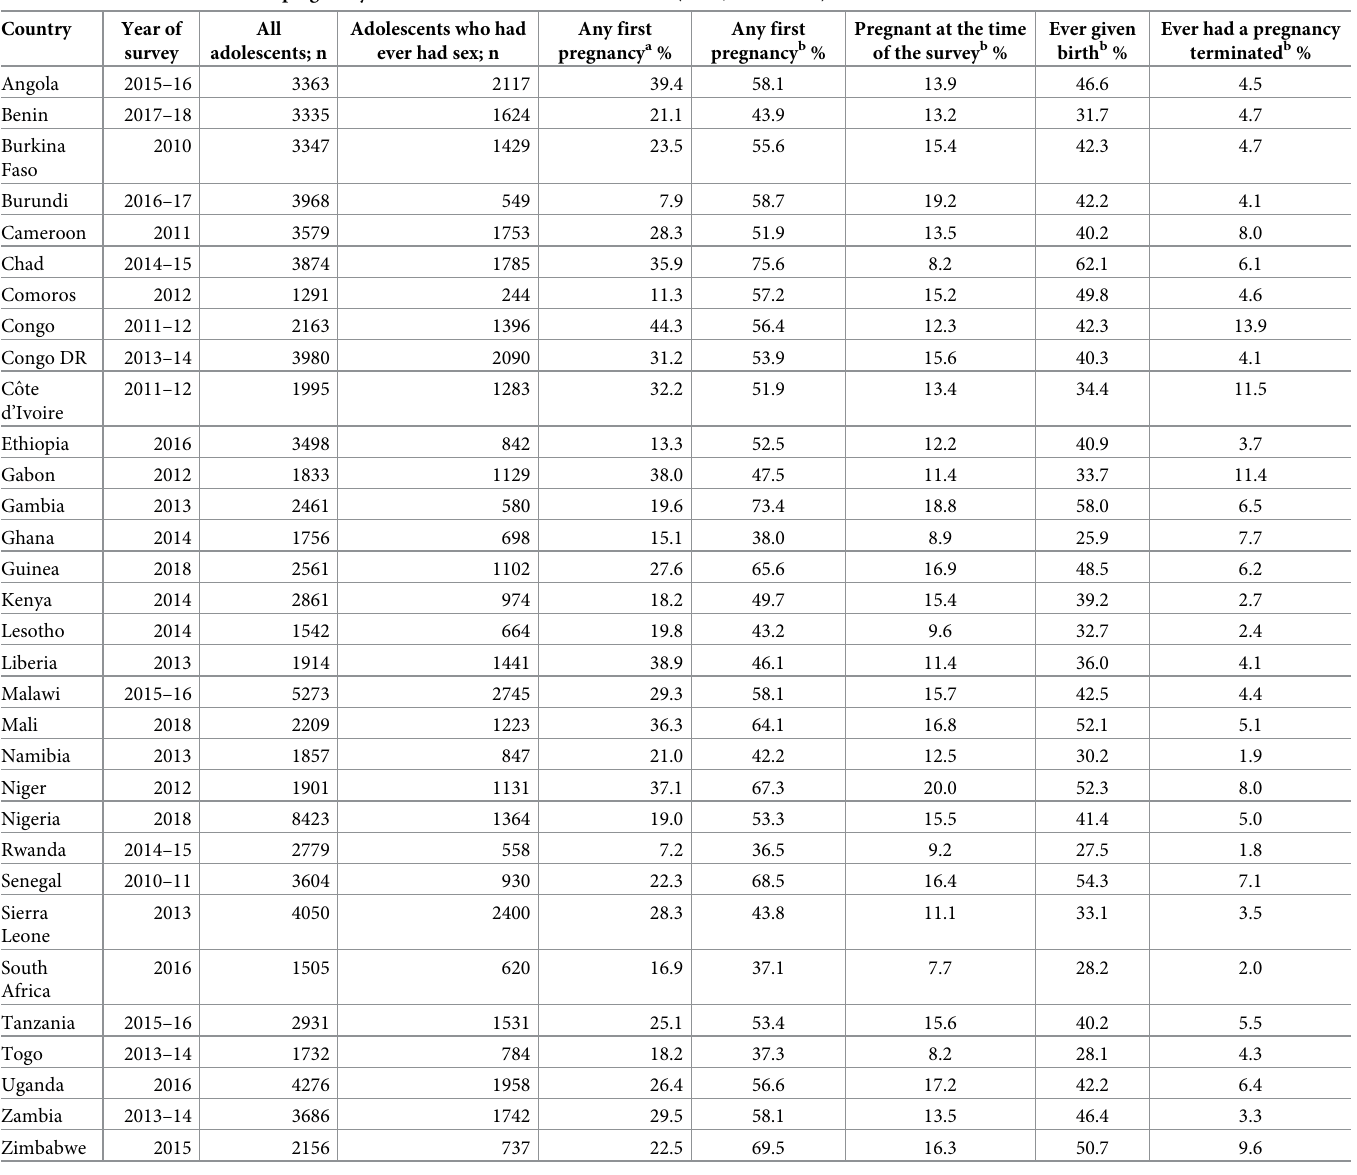
Table 1. Prevalence of adolescent pregnancy in 32 sub-Saharan African countries (DHS,